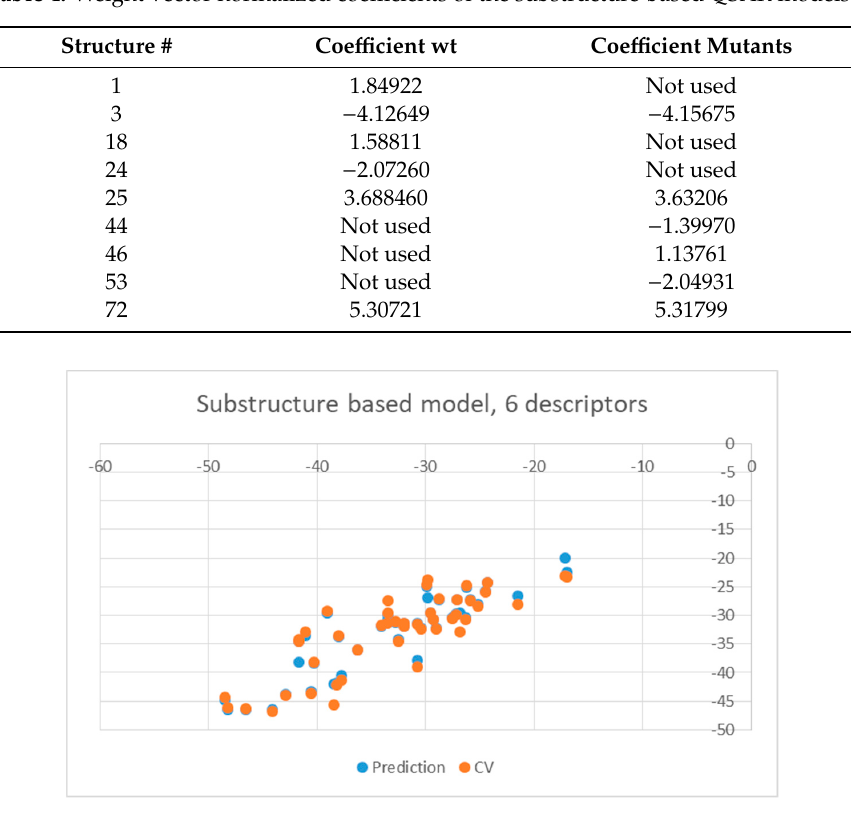
Figure 5. Obtained substructure-based QSAR results obtained with six descriptors for wild type.